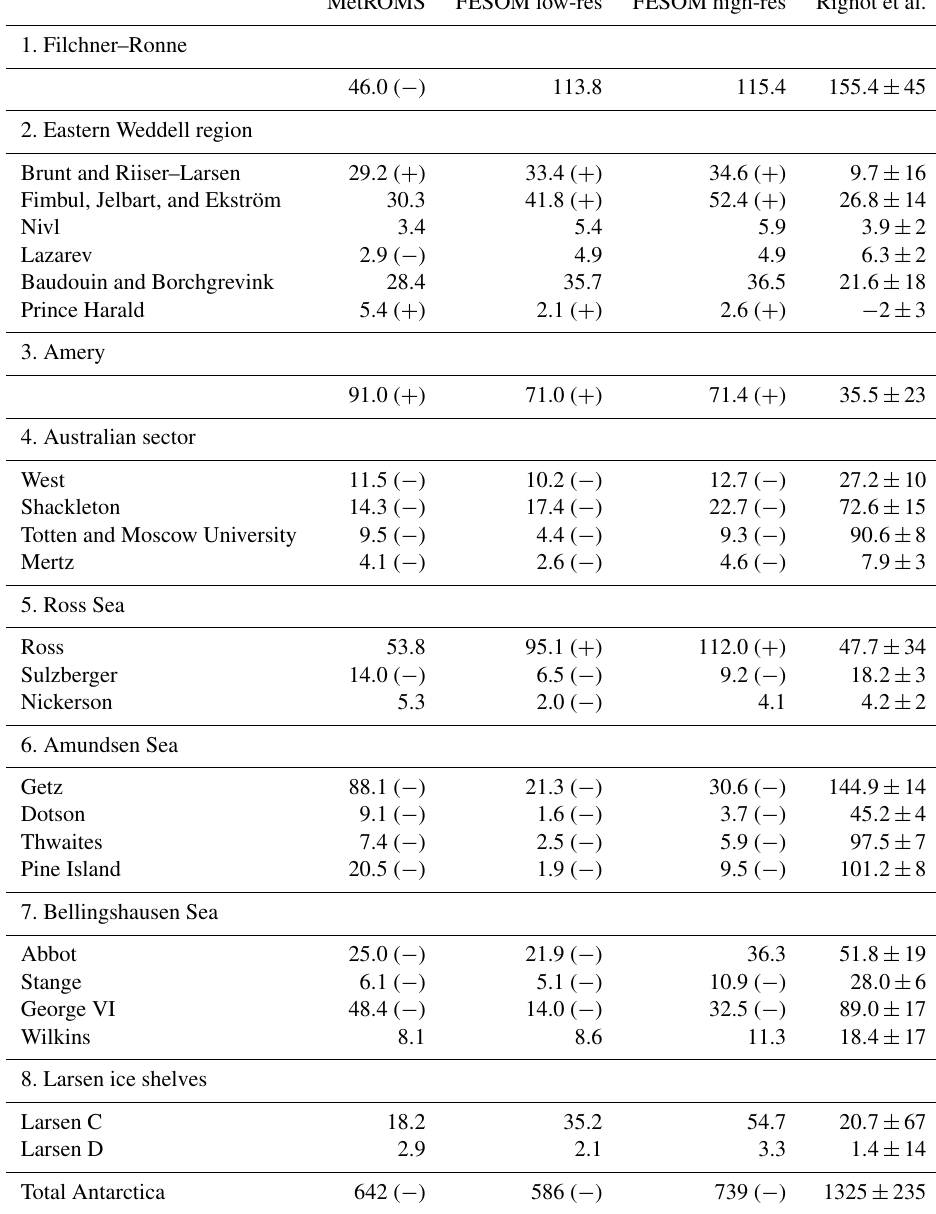
Table 1. Ice-shelf basal mass loss (Gtyr − 1 ) for all ice shelves with area exceeding 5000km 2 as measured by Rignot et al. (2013). In some cases, multiple ice shelves have been combined (e.g. Brunt and Riiser–Larsen) because the boundaries between them in the model domains are not distinct. The ice shelves have been sorted into the eight regions analysed in Sect. 4.3. Values are shown for the MetROMS, low-resolution FESOM, and high-resolution FESOM simulations averaged over the years 2002–2016 and are compared to the range of observational estimates given by Rignot et al. (2013) for the period 2003–2008. Mass loss values from model simulations are marked with ( − ) or ( + ) if they fall below or above (respectively) the range given by Rignot et al.